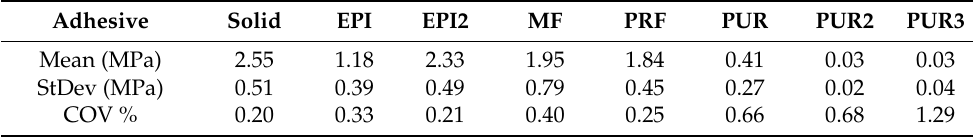
Table 2. Sample Means of Specimens Tested at 260 ◦